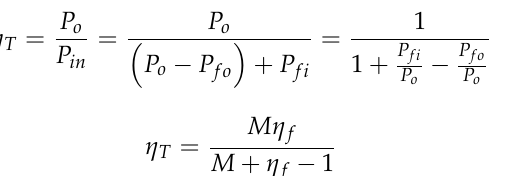
Figure 4. Power flow diagrams of the conventional flyback converter (a) and the proposed circuit (b).